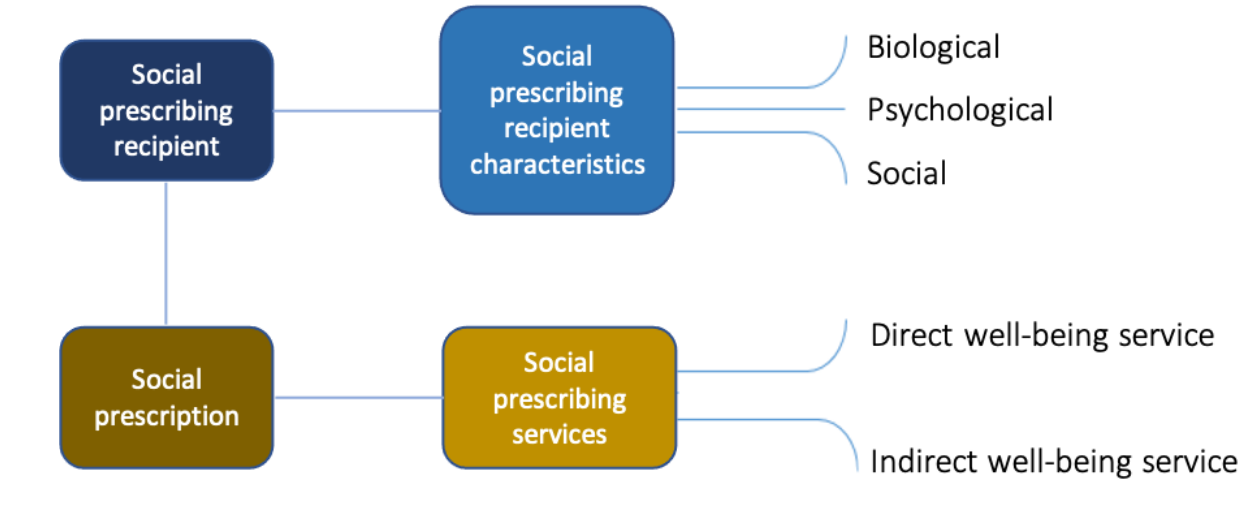
Figure 1. Design of the social prescribing ontology.